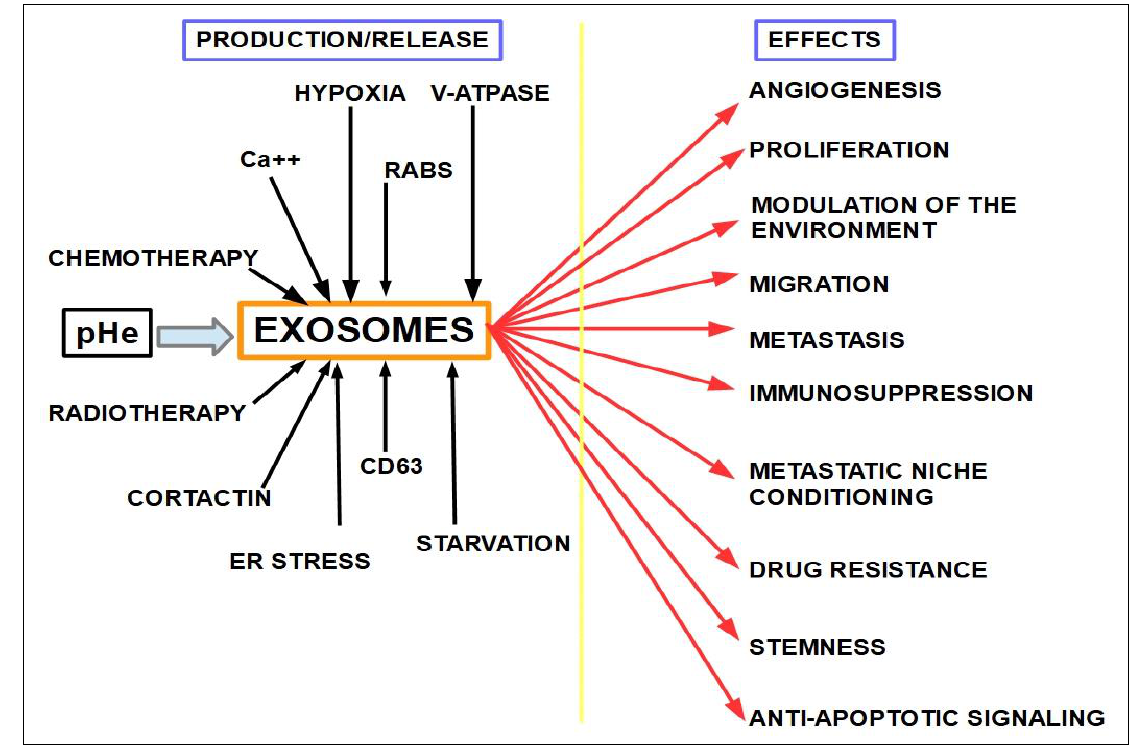
Figure 16. Factors influencing exosome formation and actions. Black arrows show mechanisms that increase exosome production, and red arrows the protumoral effects of these exosomes.